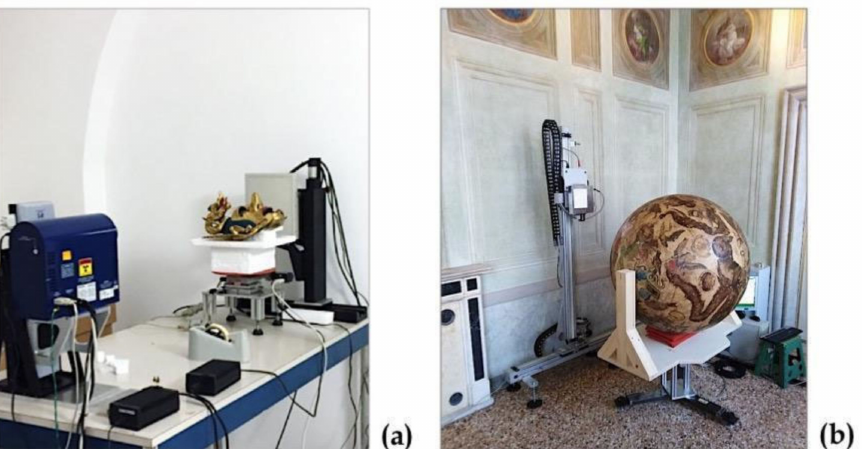
Figure 5. X-ray tomography facilities devoted to in situ CH investigations, developed by the X-ray tomography laboratory of Bologna. ( a ) picture of the setup designed for medium-size objects (up to 50 by 50 cm) during the analysis of ancient Japanese theatre masks in Rome; ( b ) photo of the facility for large-size objects, up to 150 by 150 cm, during the investigation of a Celestial Globe in